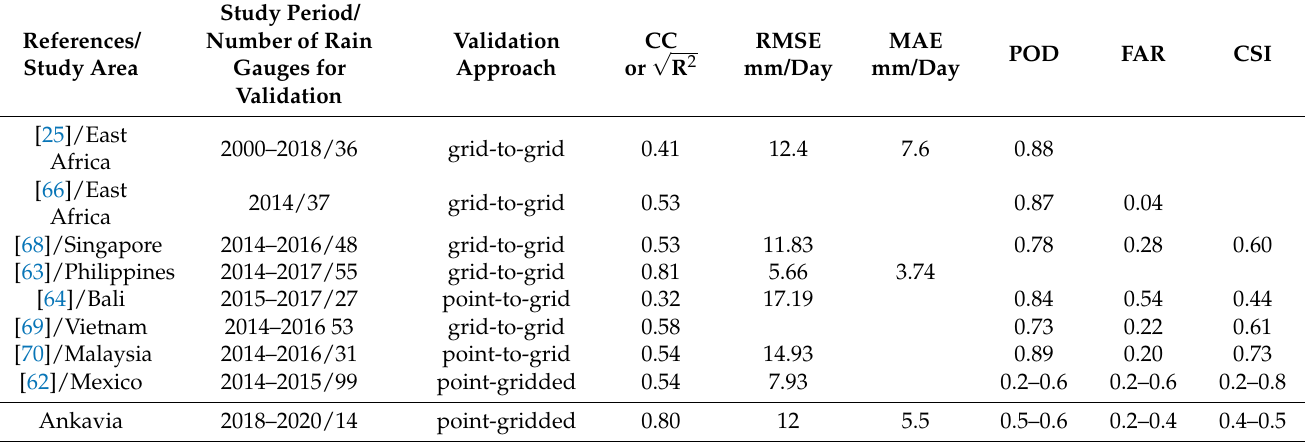
Table 3. Summary of IMERG assessment studies in tropical environments at a daily time